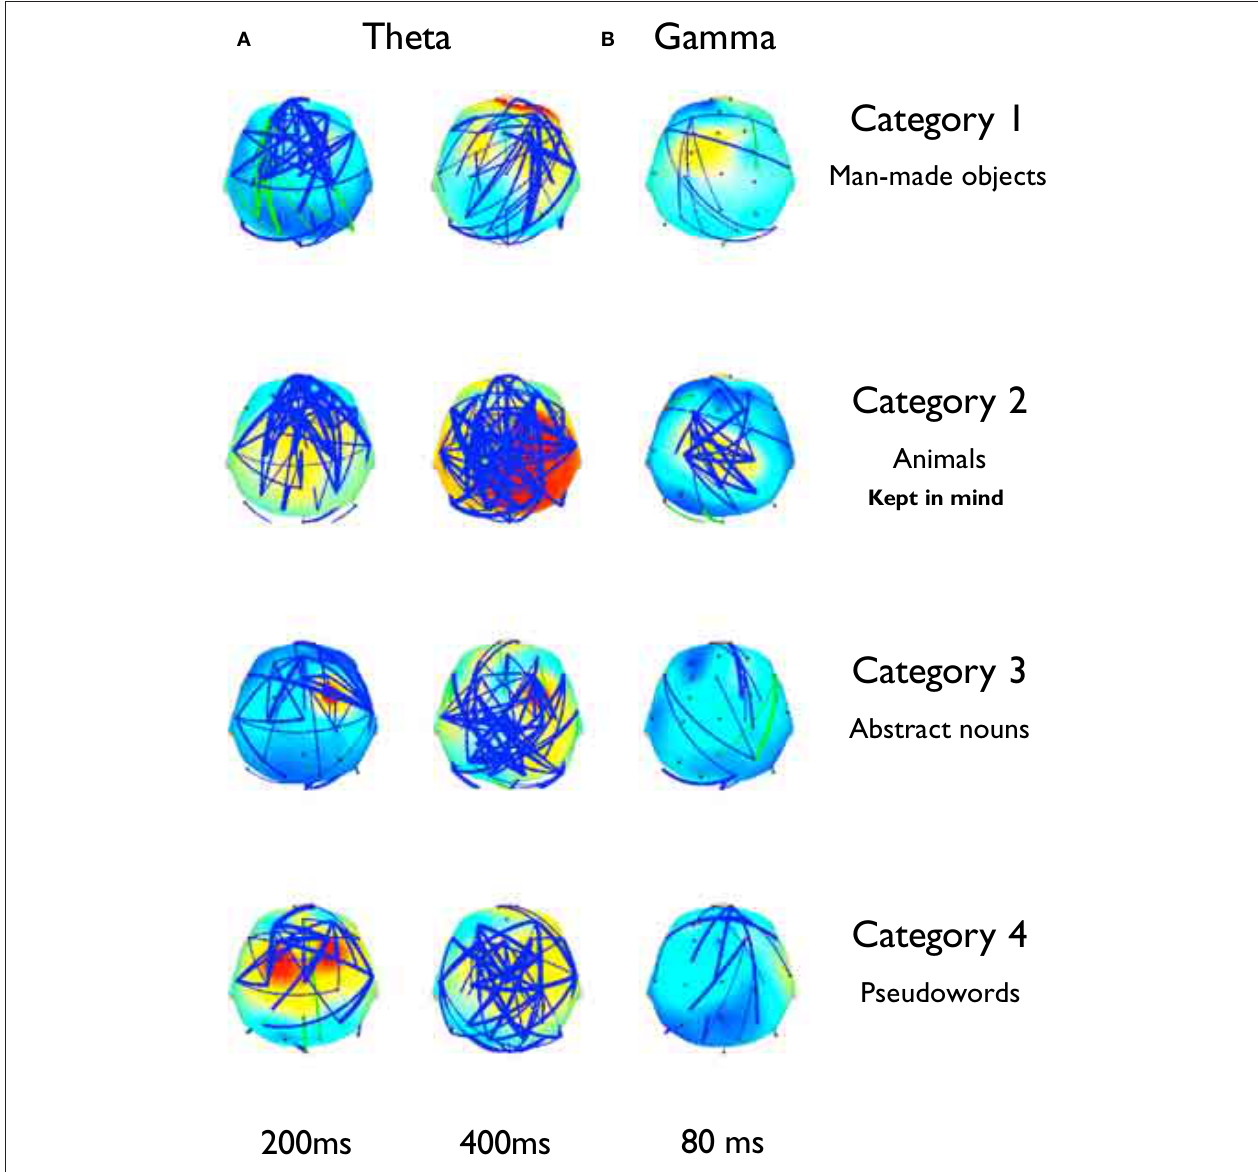
FIGURE 8 | Significant phase synchronization established between electrodes at different latencies in theta and gamma bands. Topography maps show the average significant phase synchronization established across all subjects. Whereas each subject displayed a specific topography pattern for each category, the maps show a gross average view of the inter-electrodes phase synchronization at different latencies in theta and gamma bands. (A) At 200ms, phase synchronizations in theta are generated principally at frontal locations, with category 2 showing an extended pattern to more posterior